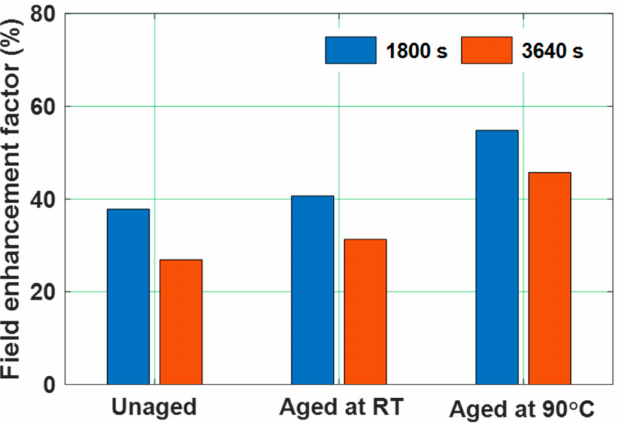
Figure 20. Field enhancement factor of unaged and water aged specimens